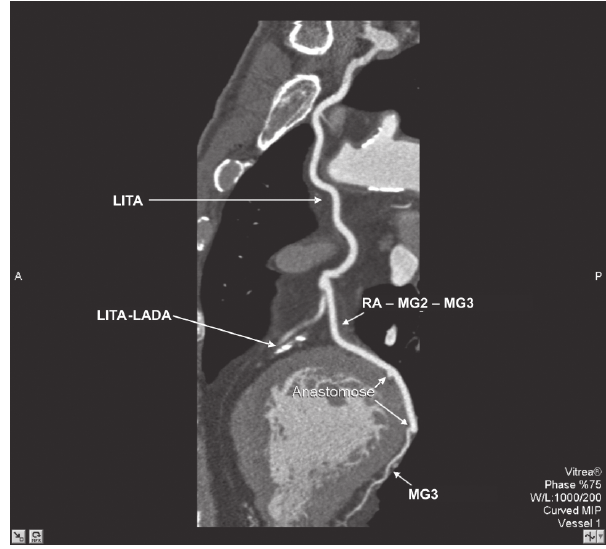
Figure 2 - Two dimensional computed tomography image for Left Internal Thoracic Artery (LITA) to Left Anterior Descending Artery (LITA – LADA) and Radial Artery to marginal branches 2 and 3 (RA – MG2 – MG3). “Anastomose” arrows indicate the respective anastomosis